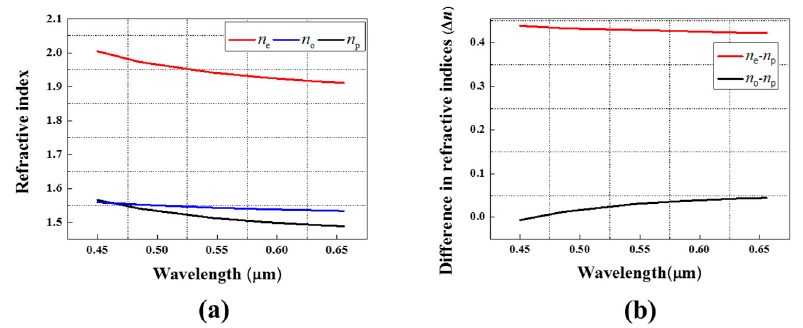
Figure 7. ( a ) Dispersion curves of (a) high- ∆ n LC of LCM 1107 and isotropic polymer of NOA81 and ( b ) ( n e − n p ) and ( n o − n p ) values.